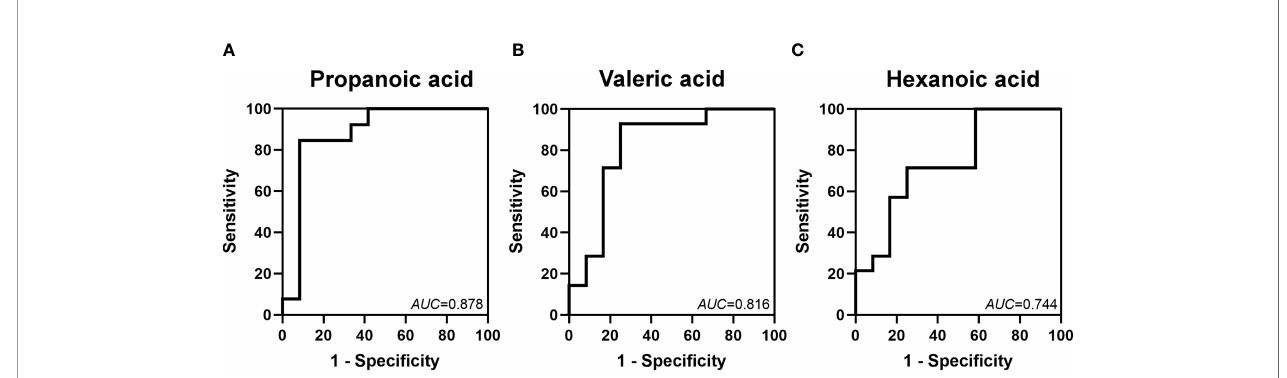
FIGURE 6 | Identi fi cation of the value of some SCFAs in the prediction of FI by ROC analysis. The AUCs of propanoic (A) , valeric (B) and hexanoic (C) acids at 2 weeks after birth were 0.878, 0.816 and 0.744,